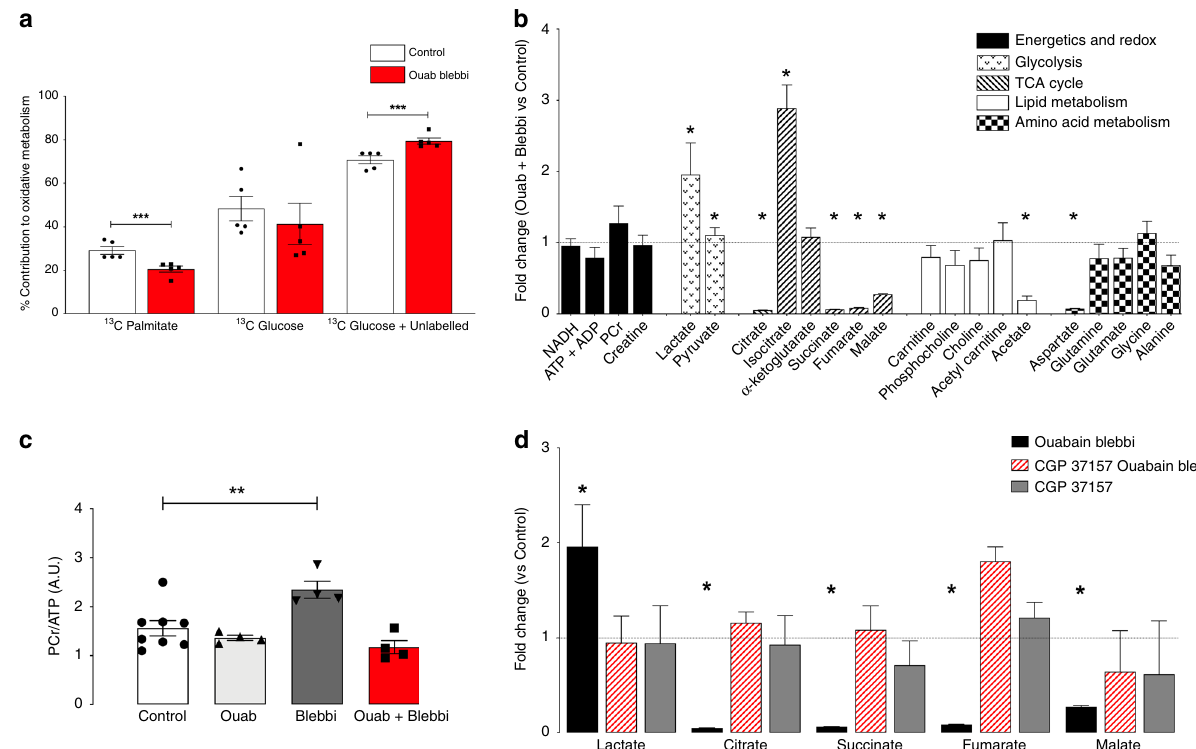
Fig. 4 Impact of acute 30 min Na i elevation on myocardial metabolism. a Myocardial 13 C NMR assessment of oxidative metabolism — % contribution of 13 C-U palmitate, 13 C 1,6 glucose and the remnant unlabelled 13 C substrate pool (pyruvate, lactate, amino acids, triglycerides, glycogen). 13 C glucose + unlabelled = 100%- 13 C palmitate oxidation) ( n = 5/group) *** P < 0.005 vs control by unpaired t-test (two-tailed, t = 3.74 df = 8). b Metabolic pro fi le plotted as metabolite fold change normalized to control concentration (control levels = 1) with propagated error (SEM). 1 H NMR metabolite analysis: NAD, ATP + ADP, PCr, creatine, carnitine, phosphocholine, choline, acetyl carnitine, acetate, aspartate, glutamine, glutamate, glycine, alanine. GC and LC-MS/ MS analysis: pyruvate, lactate, citrate, isocitrate, α ketoglutarate, succinate, fumarate, malate. C57/BL6 hearts perfused for 30 min with Control = Krebs Henseleit buffer + vehicle (DMSO); Ouab = 75 μ mol/l ouabain; Blebbi = 100 nmol/l blebbistatin; Ouab + Blebbi = 75 μ mol/l ouabain + 100 nmol/l ouabain. P < 0.005 vs control by unpaired t -test (two-tailed, df = 2.2). c Energetic reserve PCr/ATP (Control n = 8, n = 4/treatment group, * P < 0.001 vs control by one-way ANOVA F = 8.6). d Impact of the mitochondrial Na/Ca exchange inhibition with CGP37157 on GC-MS/MS metabolic pro fi le. CGP37157 + Ouab + Blebbi = 1 μ mol/l CGP37157 + 75 μ mol/l ouabain + 100 nmol/l blebbistatin; CGP37157 = 1 μ mol/l CGP37157; Control = KH buffer + vehicle (DMSO); Blebbi = 100 nmol/l blebbistatin ( n = 5/group)* P < 0.05 lactate, P < 0.0002 citrate, succinate, fumarate, malate vs control by one-way ANOVA. Data are mean ± SEM ( a , c ) and fold change versus control (control = 1) with propagated error of mean ( b , d ). Comparisons by one-way ANOVA were subject to Bonferroni multiple comparisons post-test. Source data are provided as a Source Data fi